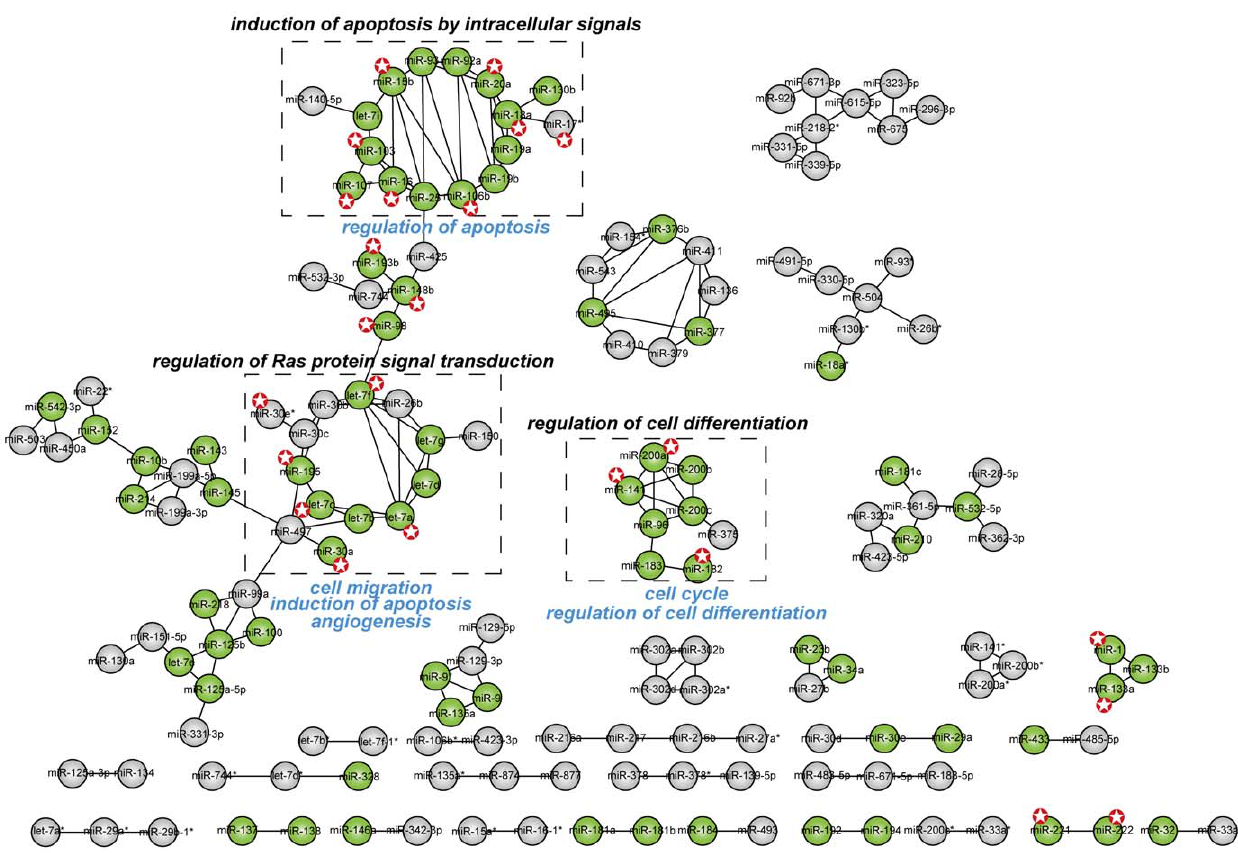
Figure 4. The human conserved miRNA co-expression network. Known disease miRNAs (green) were mapped onto the network. Three disease-related miRNA sub-networks in the dashed boxes were identified. MiRNAs with knockout/transfection experiments are labeled with red stars. Biological processes significantly overrepresented in common targets of each sub-network are recorded on top of the corresponding dashed box with black color. Using miRNAs with knockout/transfection experiments in each sub-network, biological processes significantly overrepresented in consistently affected genes are recorded at the bottom of the corresponding dashed box with blue color.